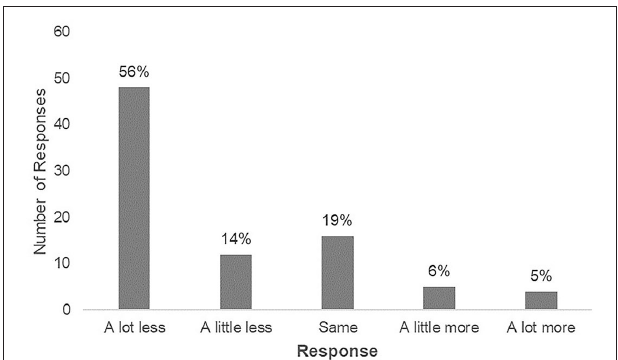
FIGURE 1 | Volunteer responses to the question “Since the beginning of the pandemic, how much time have you spent engaging with environmental stewardship